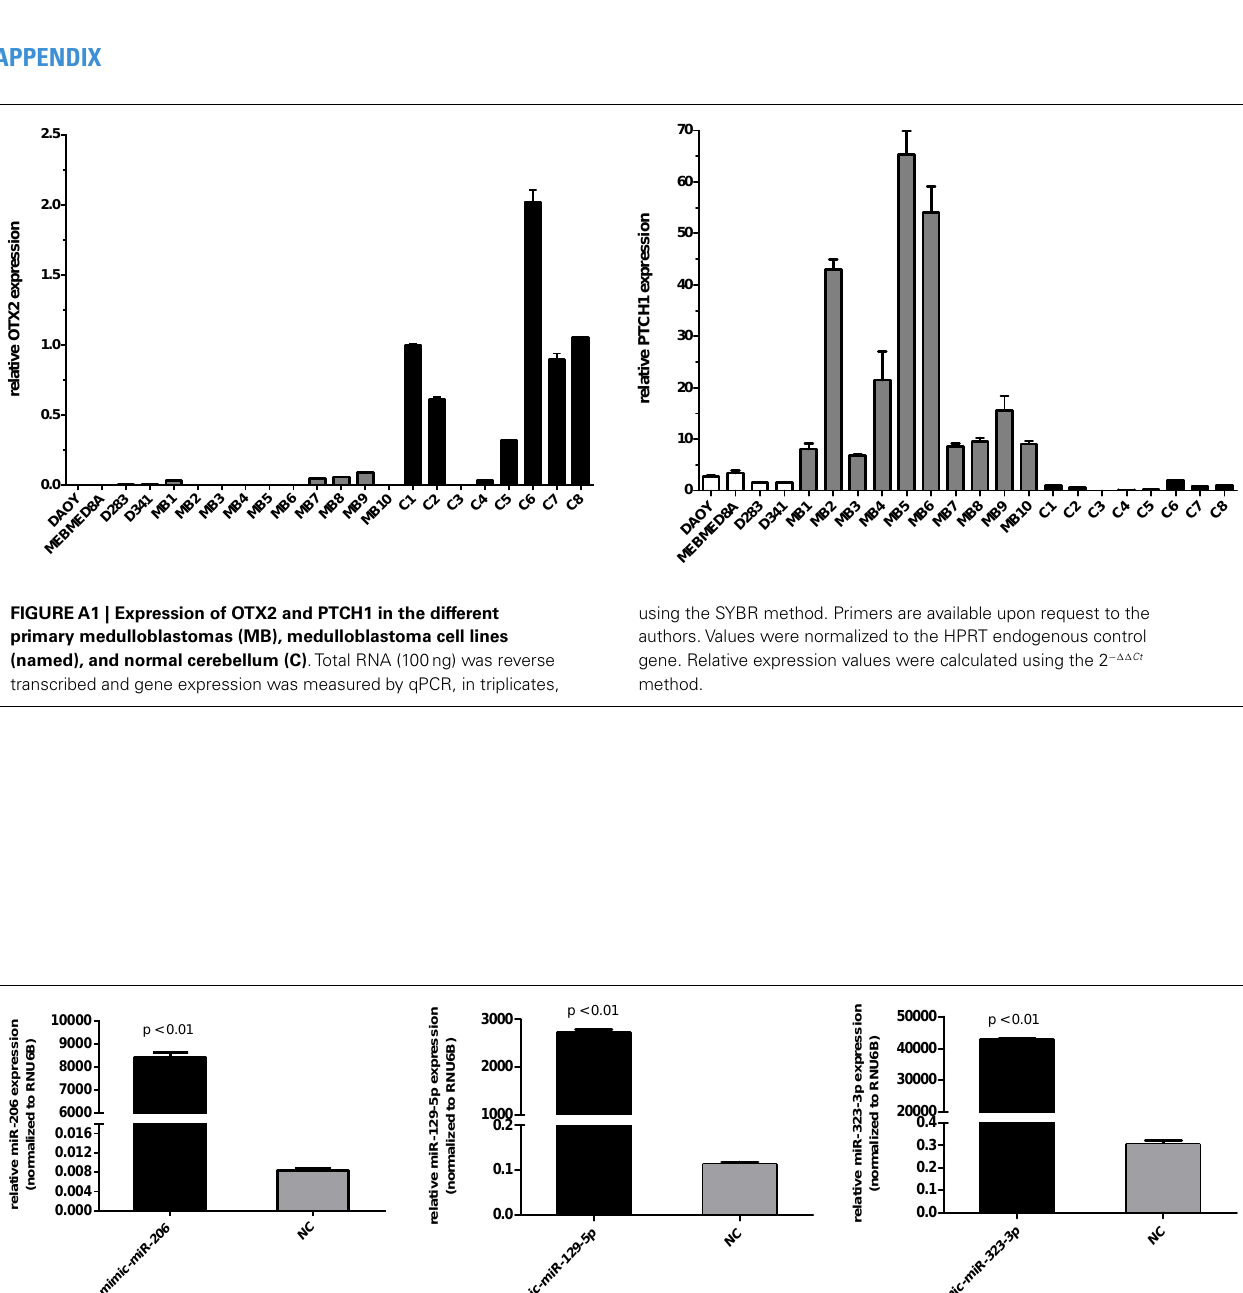
normalized to the RUN6B endogenous control RNA. Relative expression values were calculated using the 2 − ∆∆ Ct method. Bars represent mean ± SD. Comparisons were performed by the Mann–Whitney